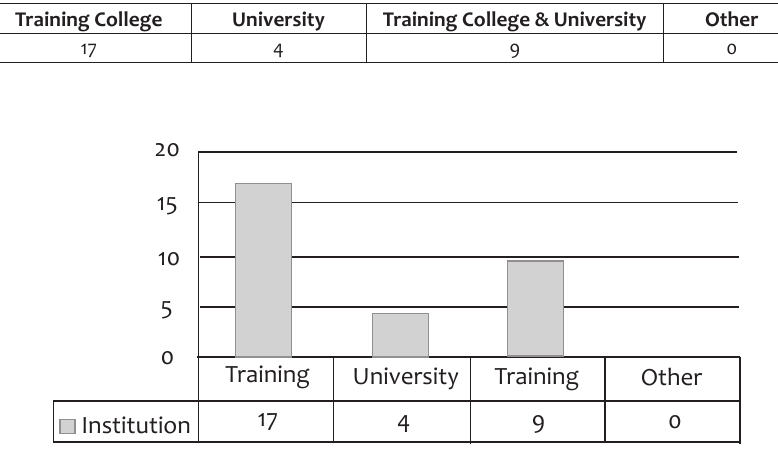
Table 1: Teachers’ training by institution